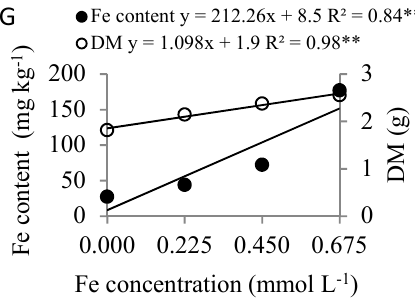
Figure 4. Leaf and dry matter (DM) content as a function of nitrogen ( A ), phosphorous ( B ), potassium ( C ), calcium ( D ), magnesium ( E ), boron ( F ) and iron concentration ( G ) in the nutrient solution on Eucalyptus spp. clonal rooted cuttings, ** significant at 1% probability using the F-test. y = -0.0005x 2 + 0.01x + 0.1